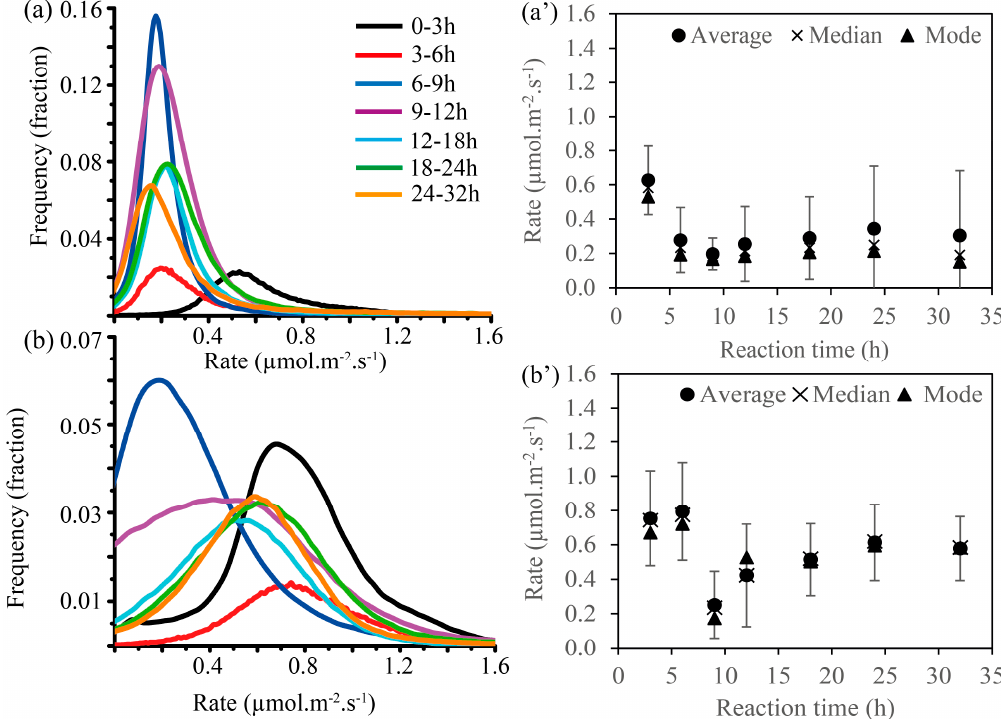
Figure 5. Rate spectra and temporal evolution of the central statistical parameters: ( a ) and ( a’ ) correspond to the striated surface (the sequence in Figure 3c); ( b ) and ( b’ ) correspond to the rate maps of the hill-and-valley surface that show also homogeneous distribution of rates (the sequence in Figure 3d). The “error” bars represent the standard deviation of the measured rates.